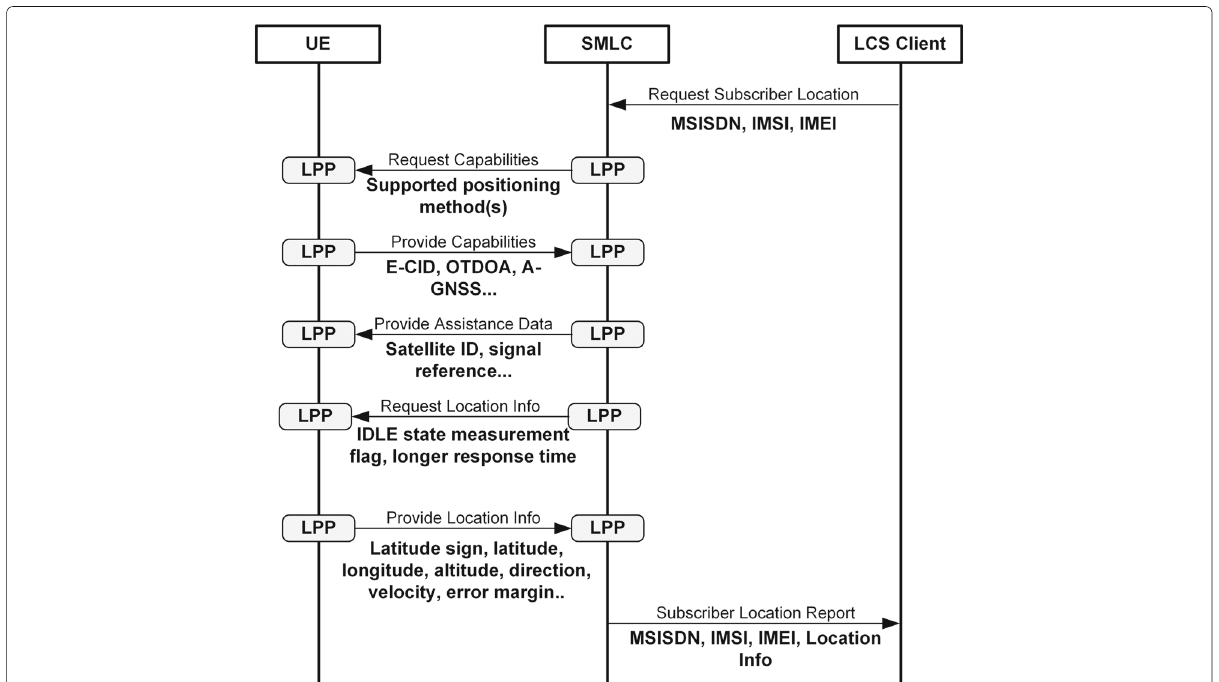
Fig. 6 The general LCS procedure in LTE/LTE-Advanced networks. For LALS-invoked user localization, the LEA is authorized as an LCS client that requests subscribers’ (target identity) localization